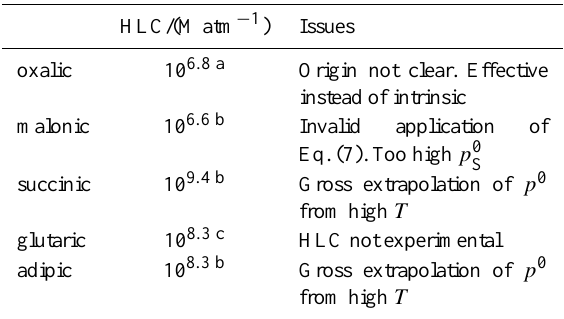
Table 1. HLC of diacids from the compilation of Raventos-Duran et al.